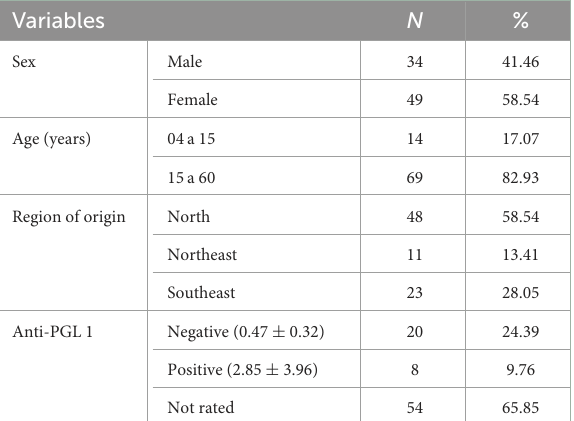
TABLE 1 Distribution of the population sample of HHDs (contacts of patients with HD) by sex, age group, region of origin, and anti-PGL-I